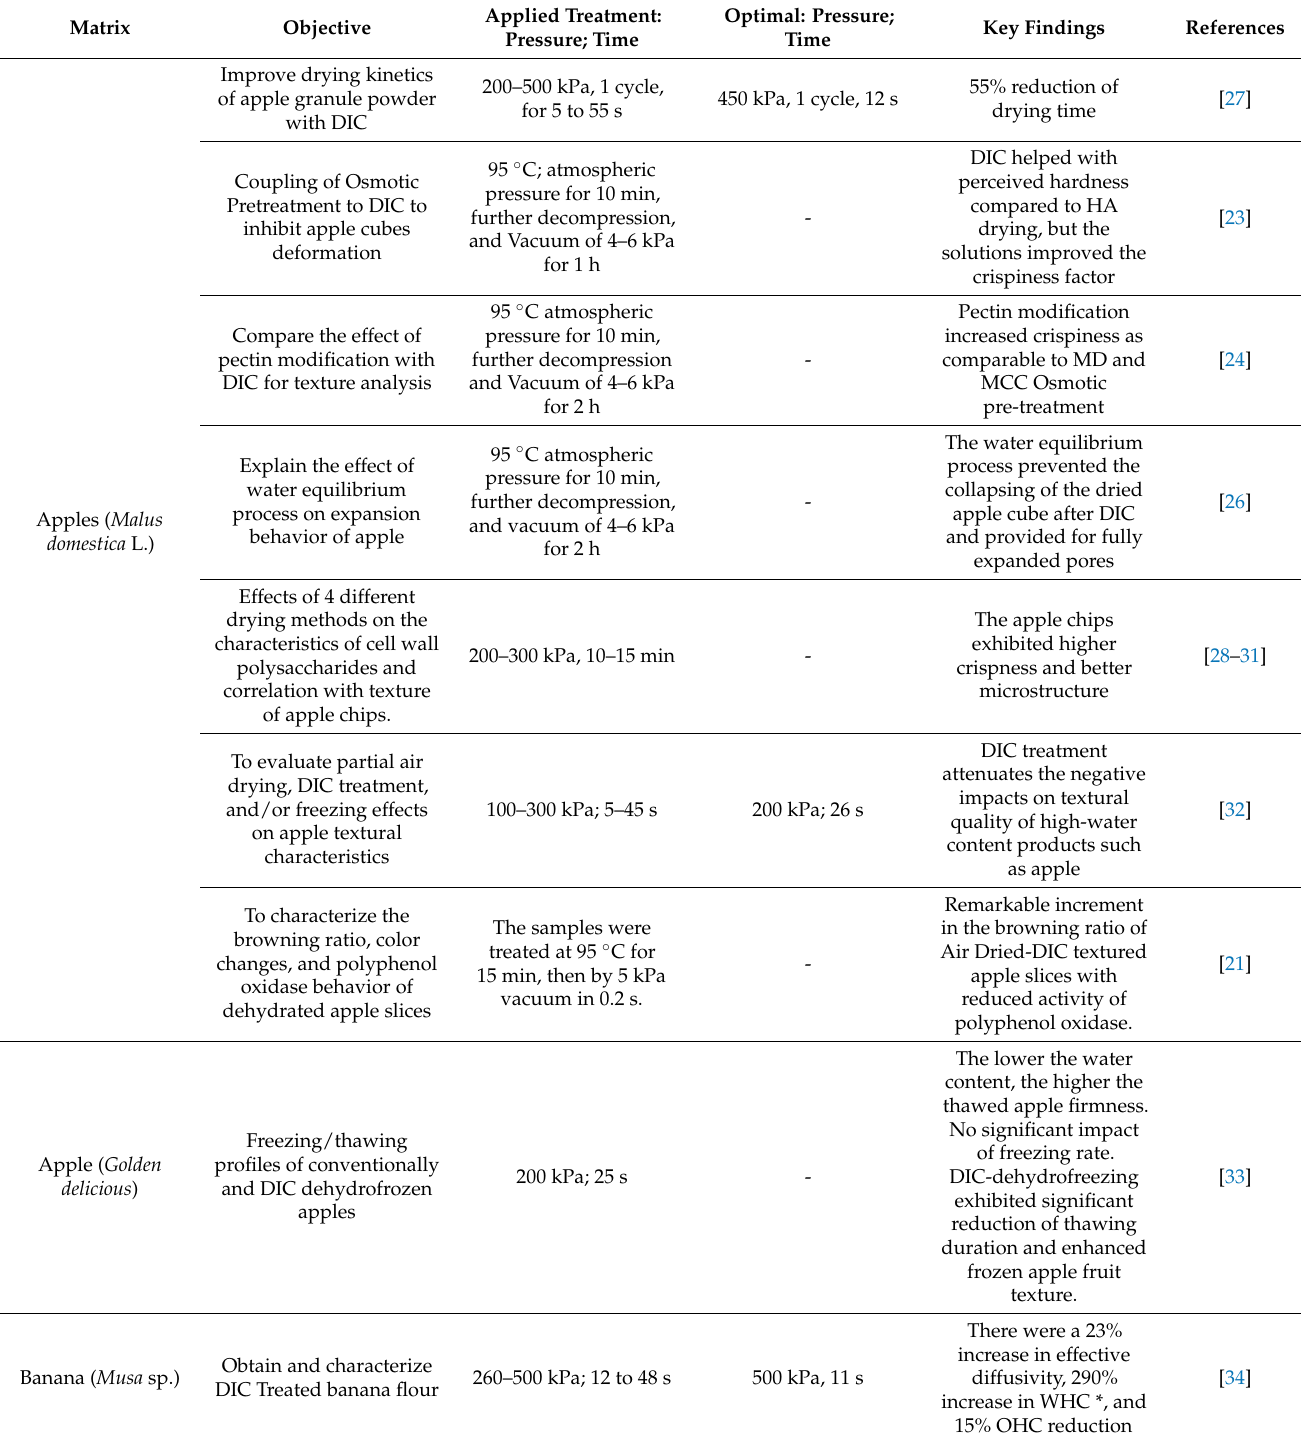
Table 1. Summary of the DIC conditions applied to treat fruits and some key